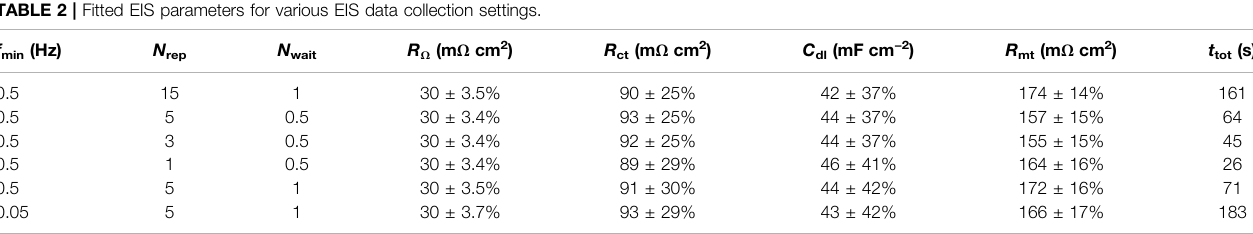
TABLE 2 | Fitted EIS parameters for various EIS data collection settings. f min